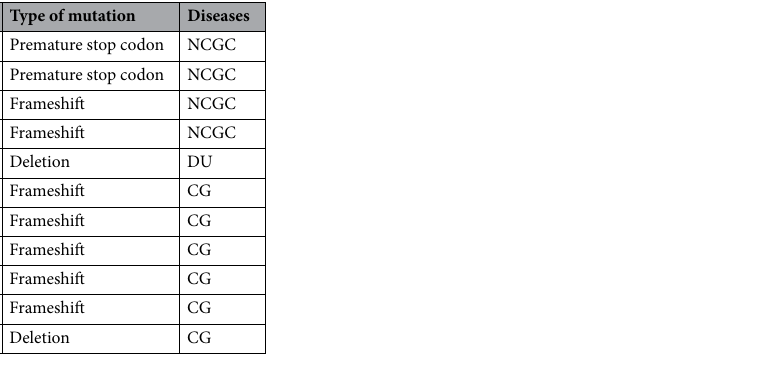
Table 4. The mutation of dupA in gastroduodenal patients in Vietnam.